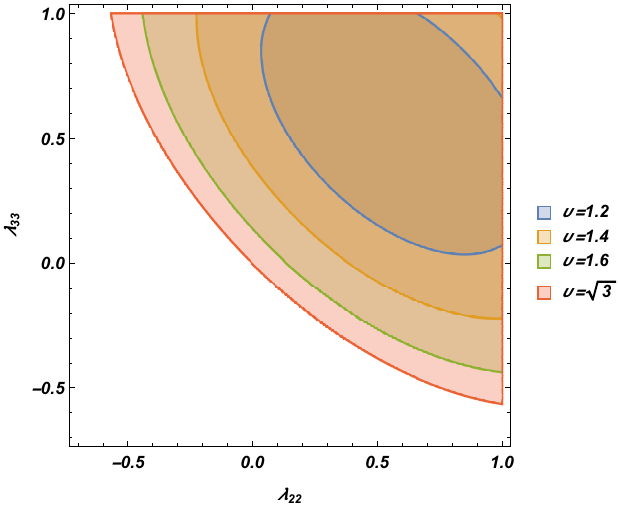
Figure 2: Shaded regions give two-qubit states useful for QKD for some specific violation amounts of CJWR inequality ob- served in the